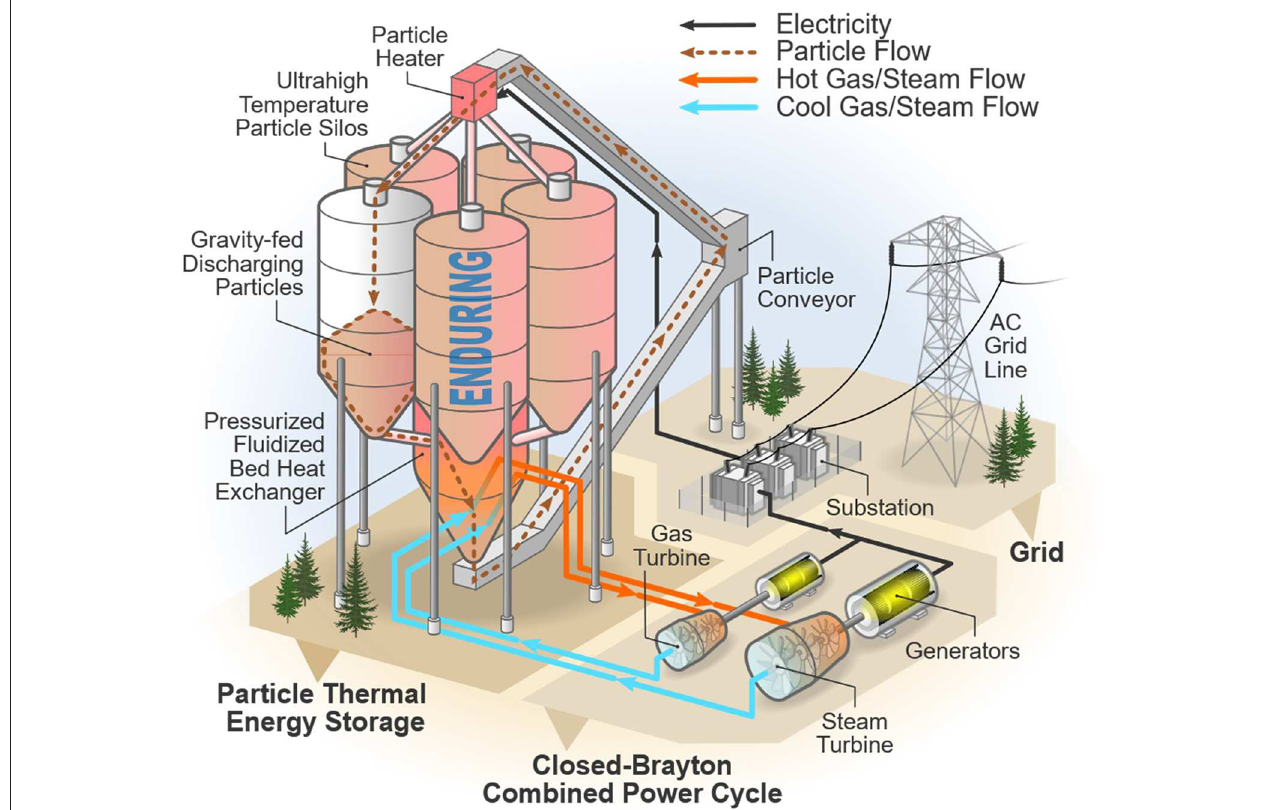
FIGURE 1 | A concept of a standalone TES grid electricity storage